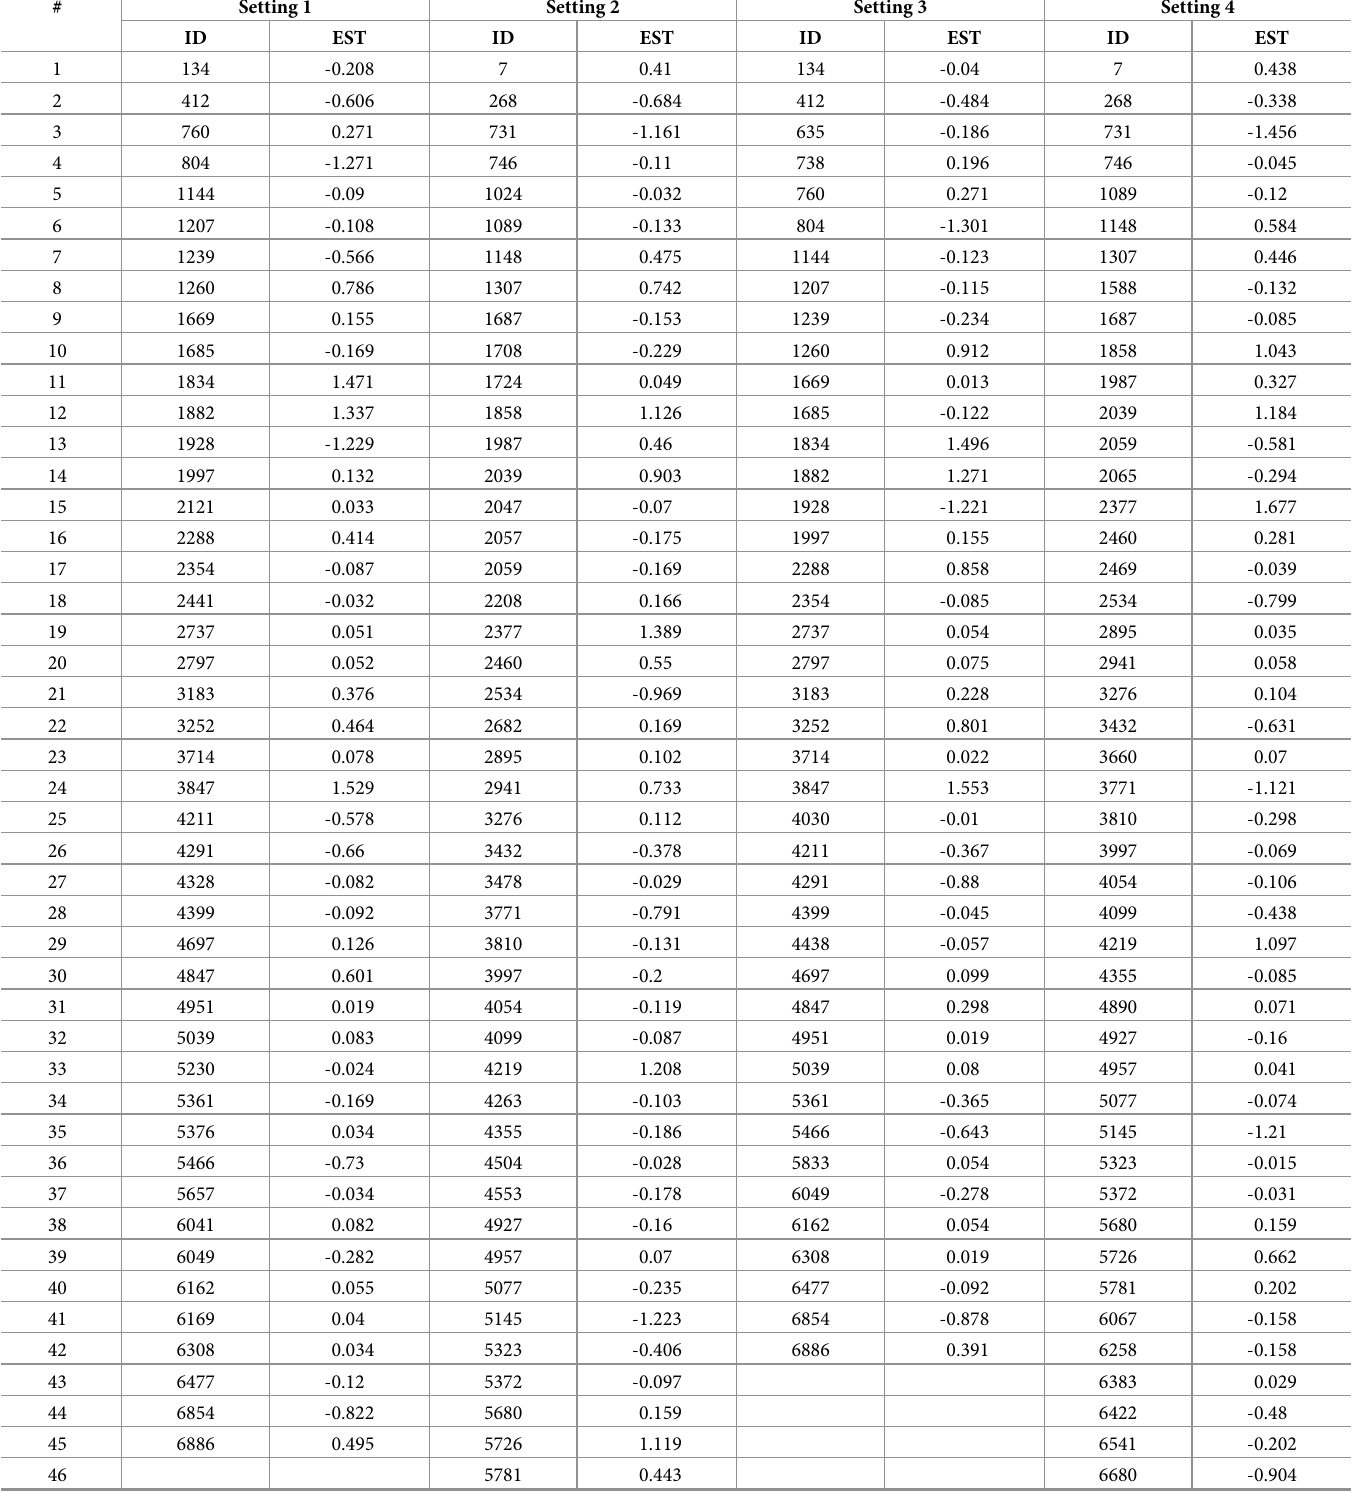
Table 1. Estimation results based on the logistic regression